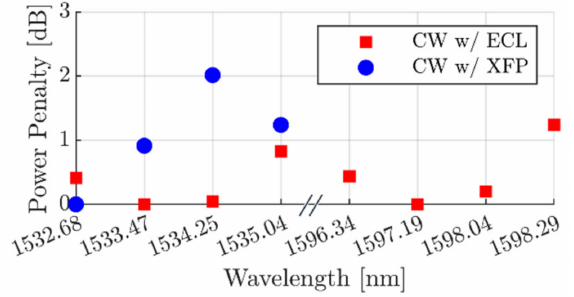
Figure 11. Power penalty on C and L